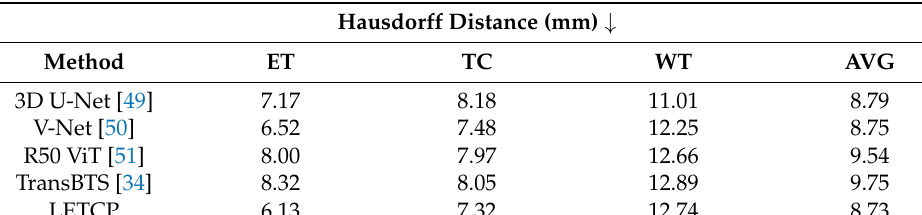
Table 4. Hausdorff Distance results comparison of LETCP and baselines on BraTS 2019 [1,3,48]. ↓ means lower is better.